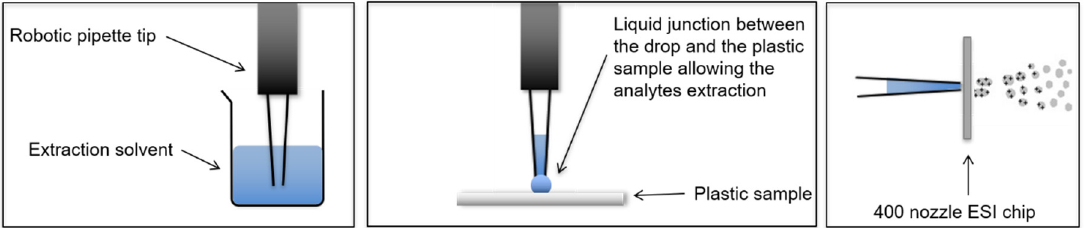
Figure 1. Liquid extraction surface analysis mass spectrometry LESA-MS principle.